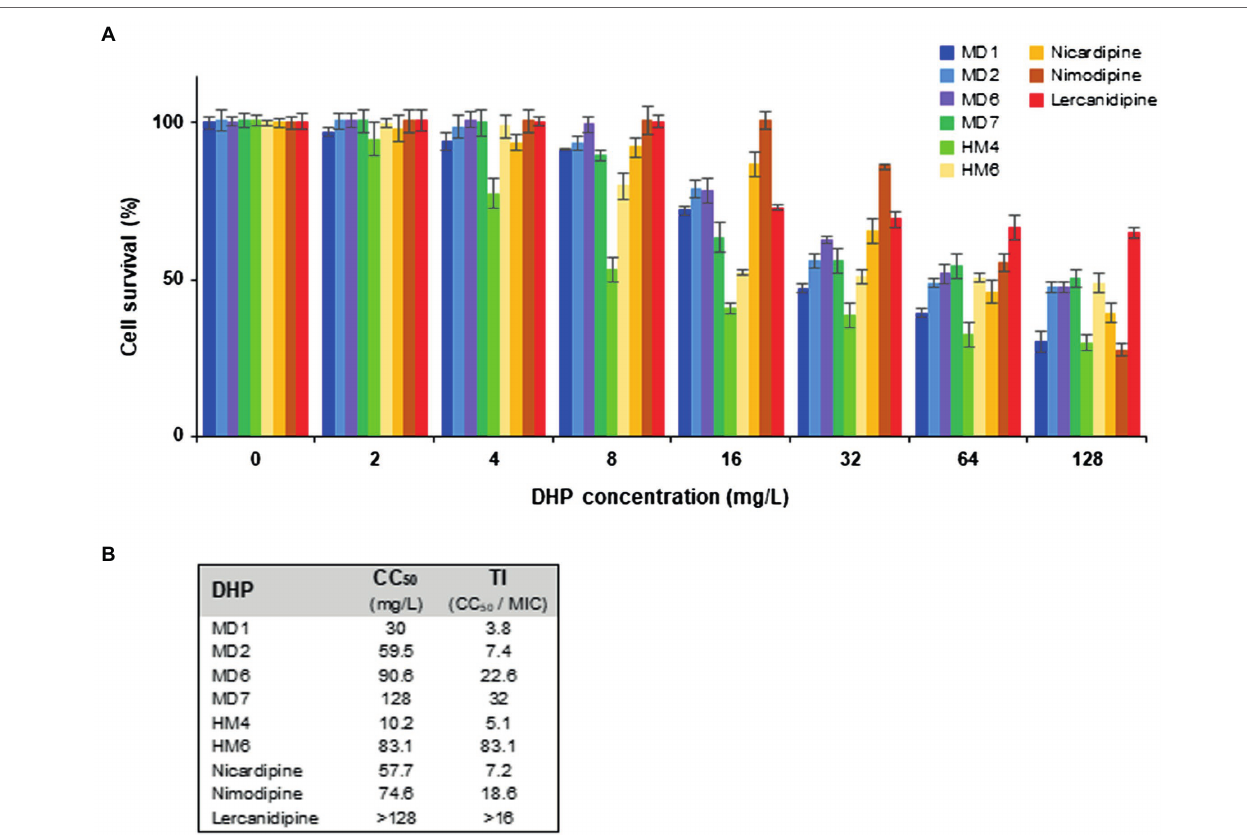
FIGURE 6 | Cytotoxicity and therapeutic index of several DHP-class anti- H. pylori compounds. (A) Cytotoxicity of selected DHP-based HHQ derivatives and some commercial DHP drugs toward HeLa cells was assessed at 24 h of exposure through the PrestoBlue method. Experiments were performed twice in triplicate, vertical bars represent SDs. (B) The 50% cytotoxic concentration (CC 50 ) was defined as the compound concentration that reduced the viability of DMSO (vehicle)- treated cell cultures by 50%. The indicated therapeutic index (TI) values were calculated as the ratio between CC 50 and the MIC value for the H. pylori strain ATCC